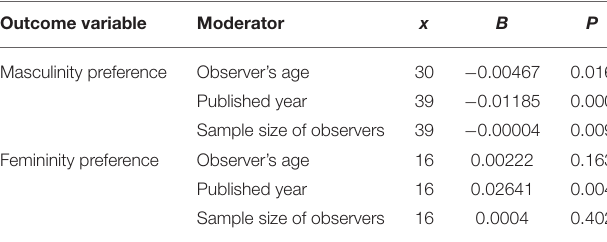
TABLE 3 | The results of the meta-regression